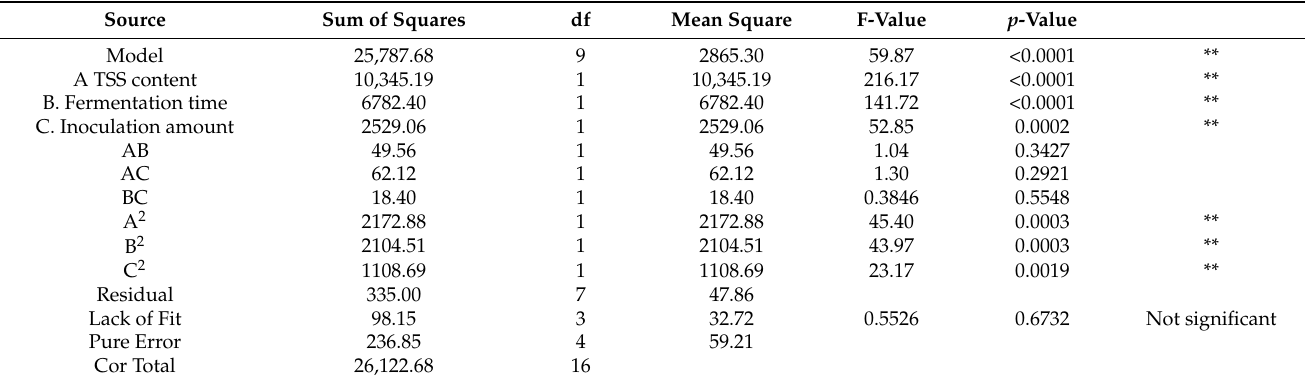
Table 6. Analysis of variance to CFJ of SOD activity.